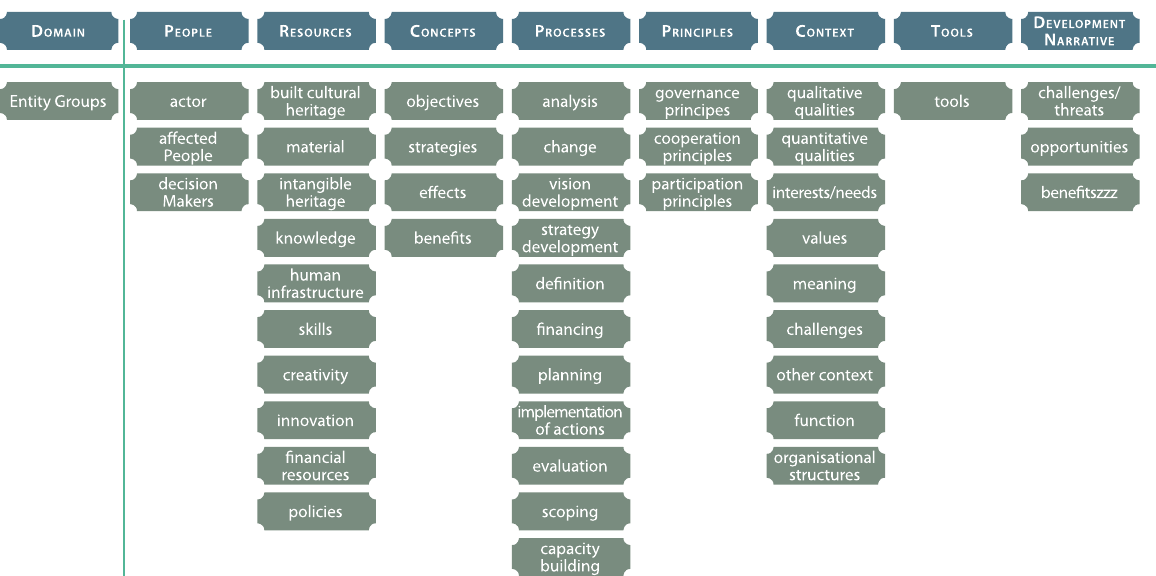
Fig. 4 Elements of the metamodel, generated with grounded theory (Source: Matthias